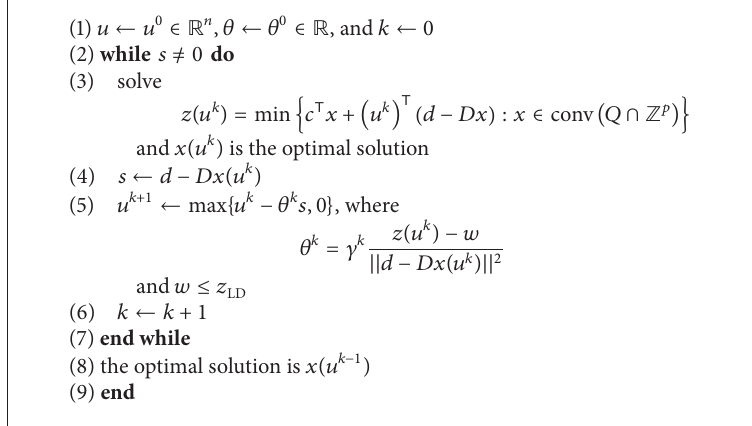
Algorithm 1: Subgradient algorithm for Lagrangian dual.